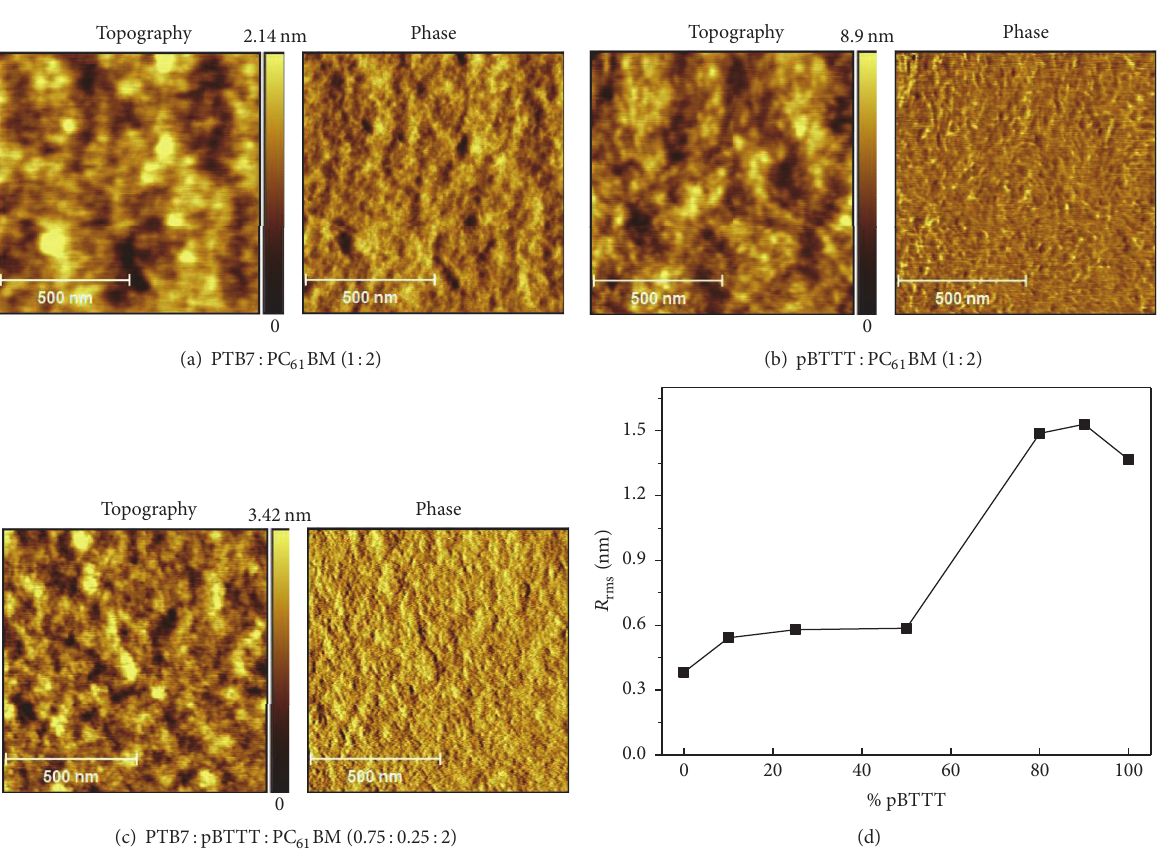
Figure 4: (a) UV-Visible absorption spectra of D : A binary blends and ternary blends deposited onto quartz/PEDOT :PSS substrates. (b) EQE spectra of the corresponding solar cells.